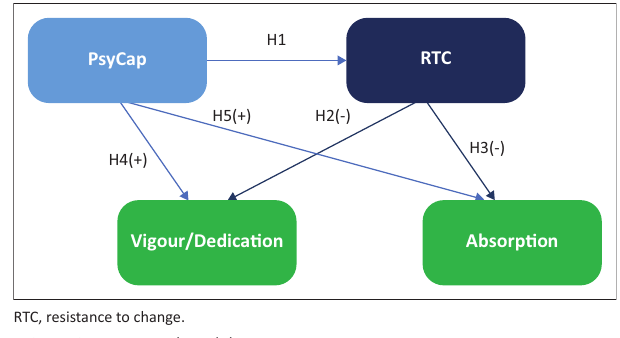
FIGURE 2: Conceptual